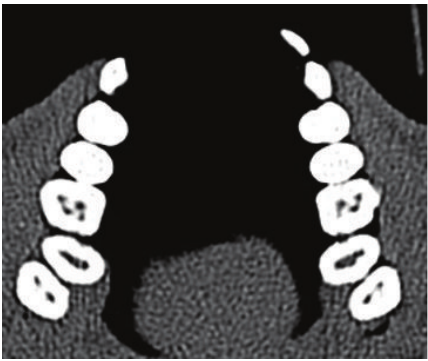
Figure 1: Axial view demonstrating MB2 in maxillary right first molar.